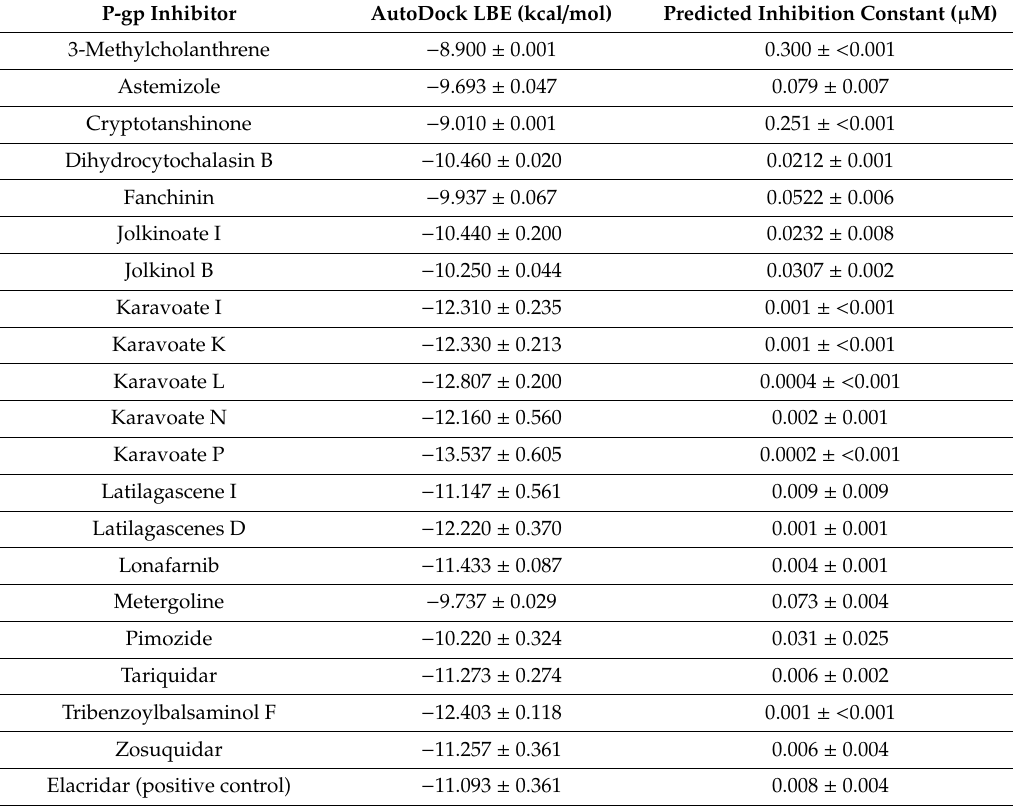
Table 8. Lowest binding energies (LBE) and predicted inhibition constants obtained by molecular docking of the top 20 P-gp